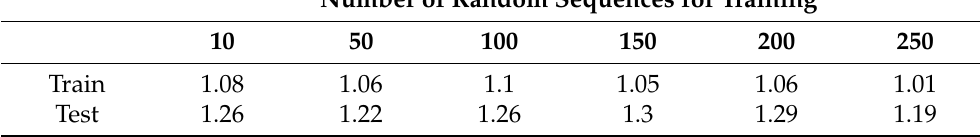
Table 6. Average RMSE behavior in train and test sets changing the number of random sequences for training the GRU (250 Cells) + Dense model.